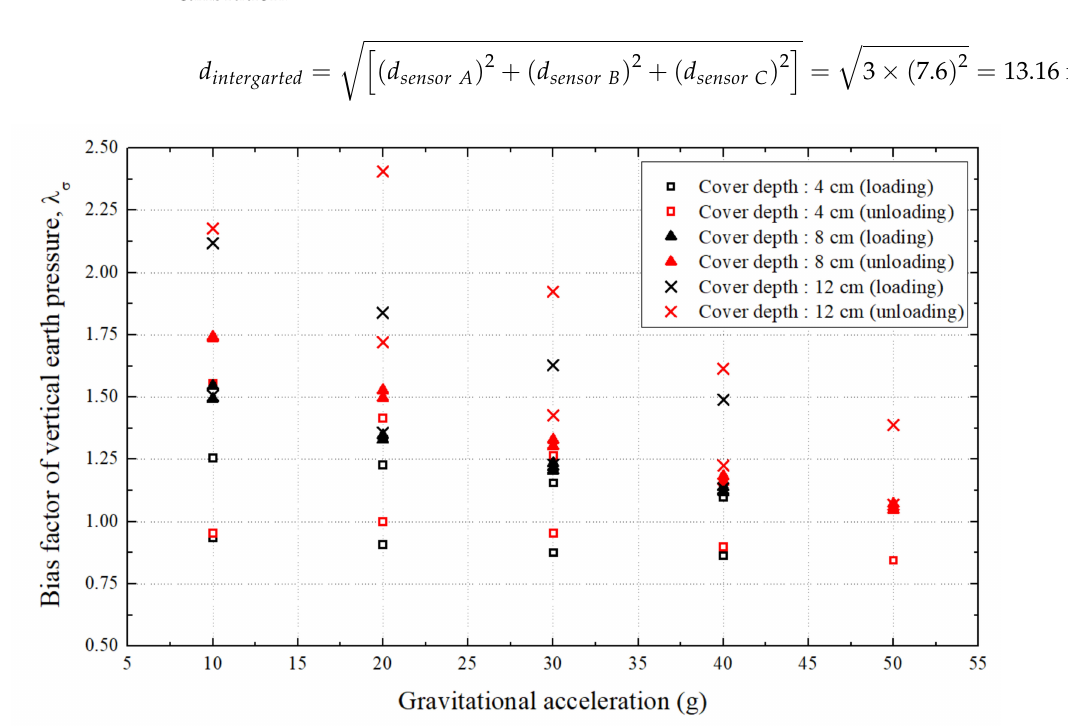
Figure 13. Recalculation of data after sensor size